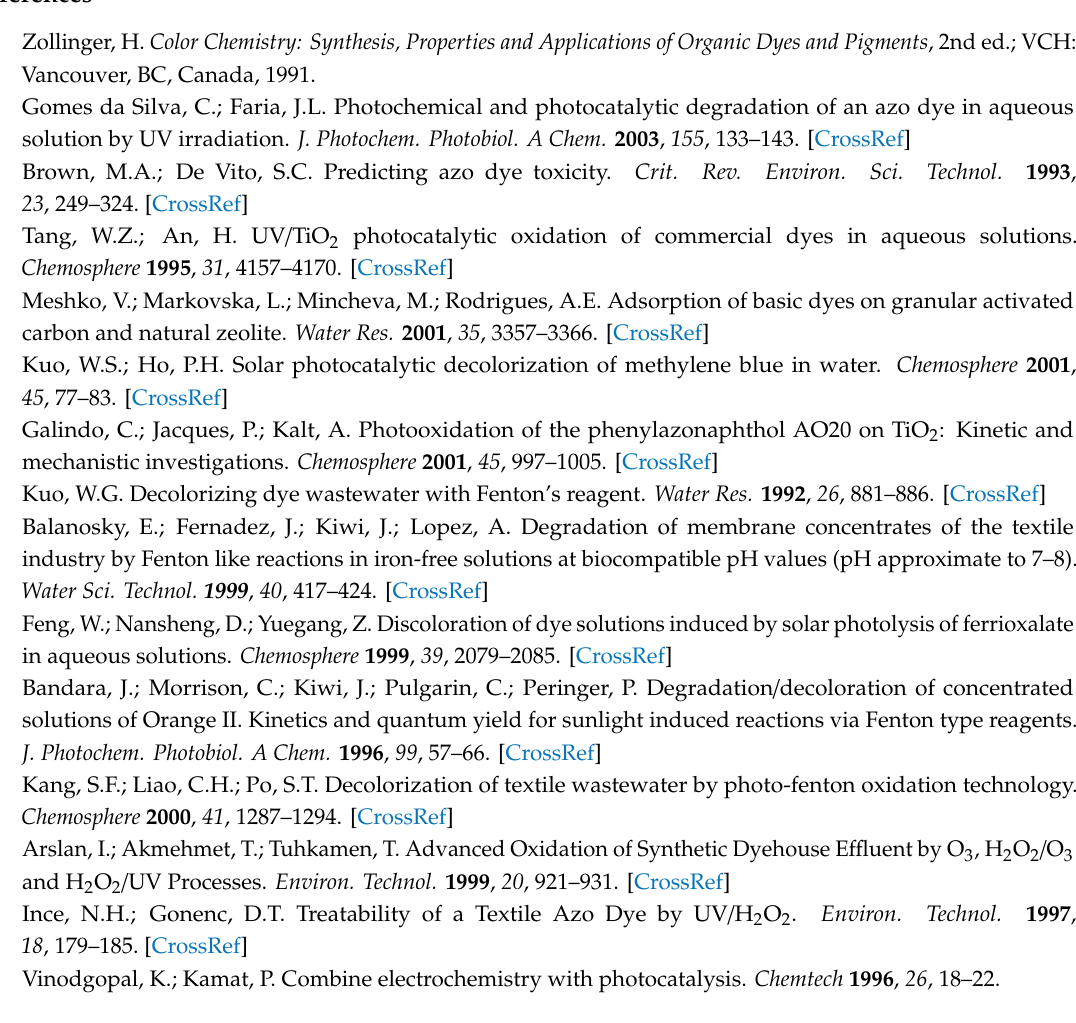
Figure S1: Open circuit chronopotentiometry, Figure S2: Cyclic voltammetry of MO at a glassy carbon electrode, Figure S3: Experimental vs computed MO spectrum, Figure S4: Cyclic voltammetry of TiO 2 in HCOONa, Figure S5: Cyclic voltammetry of TiO 2 in Na 2 SO 4 , Figure S6: Cyclic voltammetry of MO at a TiO 2 electrode, Figure S7: 430 nm kinetics in pure water, Figure S8: 720 nm decay kinetics, Figure S9: ESI-MS spectrum in AO7 (10 ppm) and ethanol (10% v / v ), Figure S10: ESI-MS spectrum in